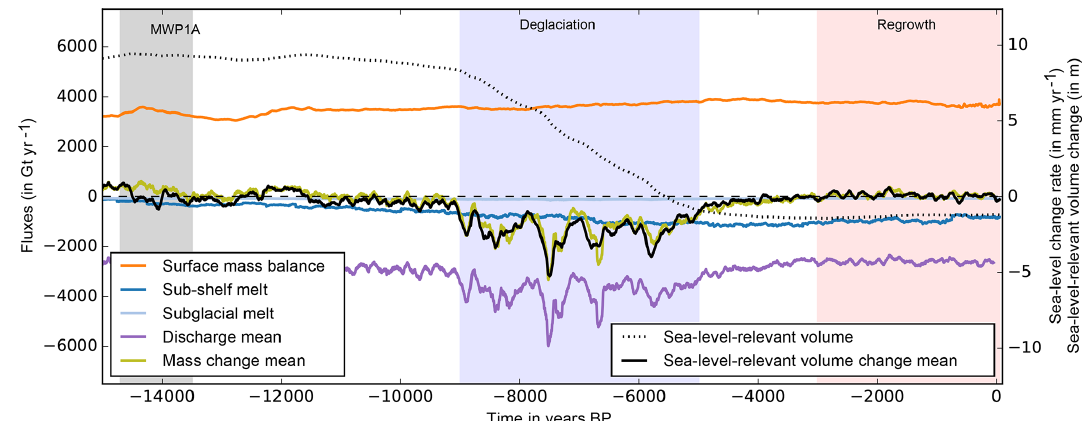
Figure 17. Mass fluxes over the last 15kyr for the best-fit simulation ( y axis), with the sum of surface (orange) and basal mass balance (blue; subglacial melt in light blue is negligible) and discharge (100-year running mean in violet) yielding total mass change (khaki). Mass change agrees well with sea-level-relevant volume change (100-year running mean in black; x axis). Main deglaciation occurs between 9 and 5kyrBP (black dotted line; x axis), at on average 2.0mmyr − 1 , or 1000Gtyr − 1 (blue bar), significantly after MWP1a (grey bar). In the last 3kyr of the best-fit simulation, the Antarctic Ice Sheet regains mass by about 60Gtyr − 1 , which equals about 0.07mmyr − 1 SLE (red bar).